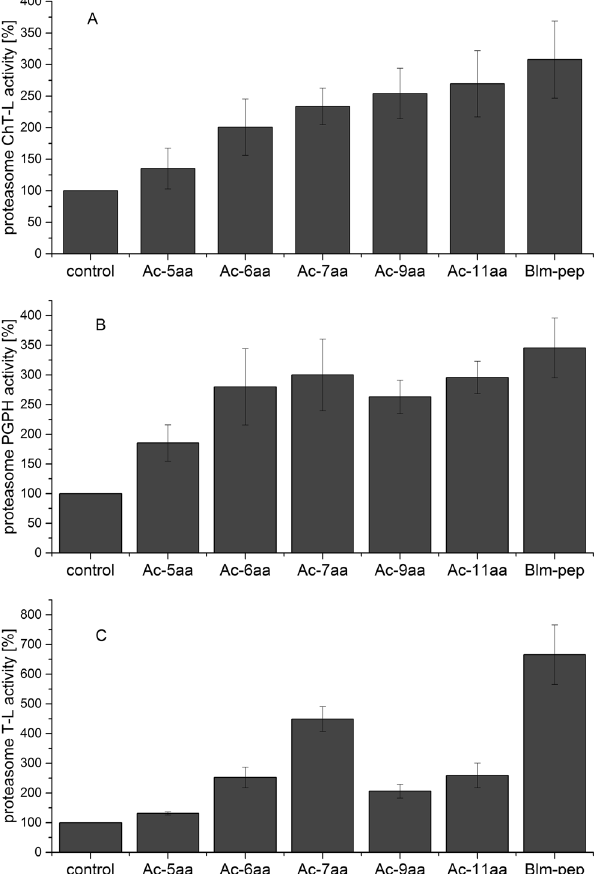
Figure 1. Activation of different proteolytic activities of the latent human 20S proteasome by Blm-pep and its acetylated analogs: ( A ) ChT-L, ( B ). PGPH, ( C ). T-L peptidase activity. The peptides concentration was 10 μ M. Results are expressed as a percentage of activity of the latent human 20S proteasome. The variability of the data is presented as standard deviation error